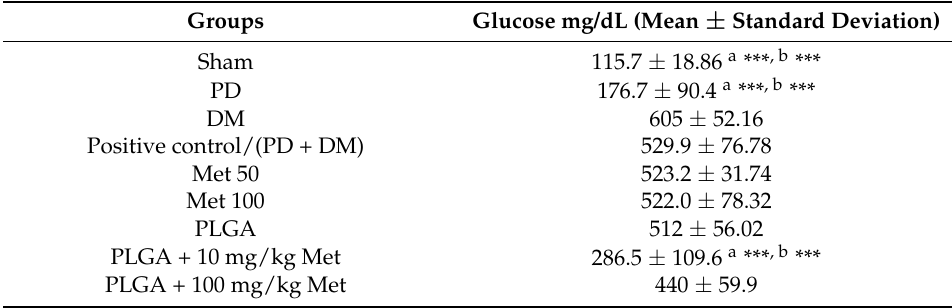
Table 2. Glucose of animals/group, Natal, RN, Brazil, 2018.